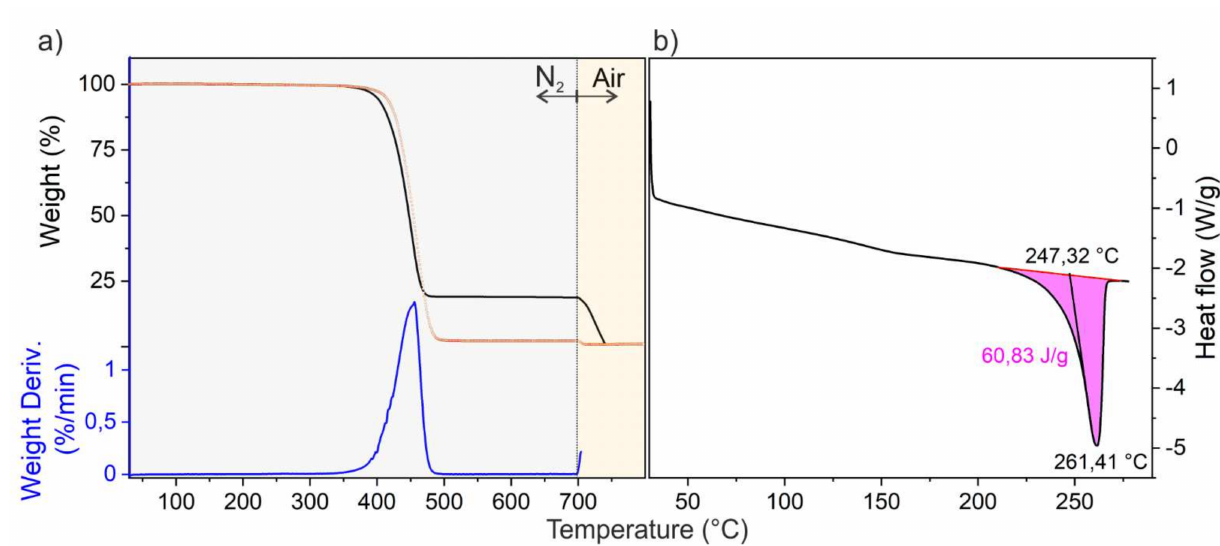
Figure 1. Thermograms of the PA CB-17 composite material: TGA and DTGA plots obtained under N 2 (up to 700 ◦ C) and air flow (from 700 ◦ C up to 800 ◦ C) (black and blue curves, respectively) ( a ) and DSC analyses (only the second heat cycle is reported) ( b ). In ( a ) TGA plot of pure PA66 is shown for comparison (red dotted line).